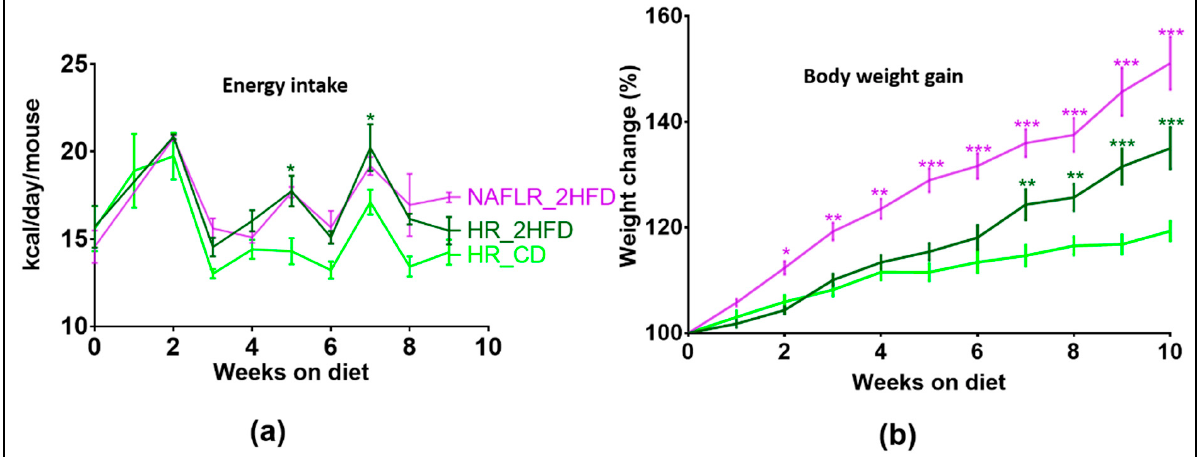
Figure 3. ( a ) Food energy intake (kcal/day/mouse), n = 12 mice/group and ( b ) mice body weight gain (%) follow-up, n = 12 mice/group. HR, healthy human microbiota receiver mice; CD, control diet; 2HFD, high-fructose, high-fat diet; NAFLR, NAFL patient microbiota receiver mice; HR_CD, HR mice on CD; HR_2HFD, HR mice on 2HFD; NAFLR_2HFD, NAFLR mice on 2HFD; green (* p < 0.05, ** p < 0.01, *** p < 0.001) is used for diet impact (HR + 2HFD vs. HR + CD) statistical comparisons and purple (* p < 0.05, ** p < 0.01, *** p < 0.001) is used for microbiota impact (NAFLR_2HFD vs. HR_2HFD) statistical comparisons.